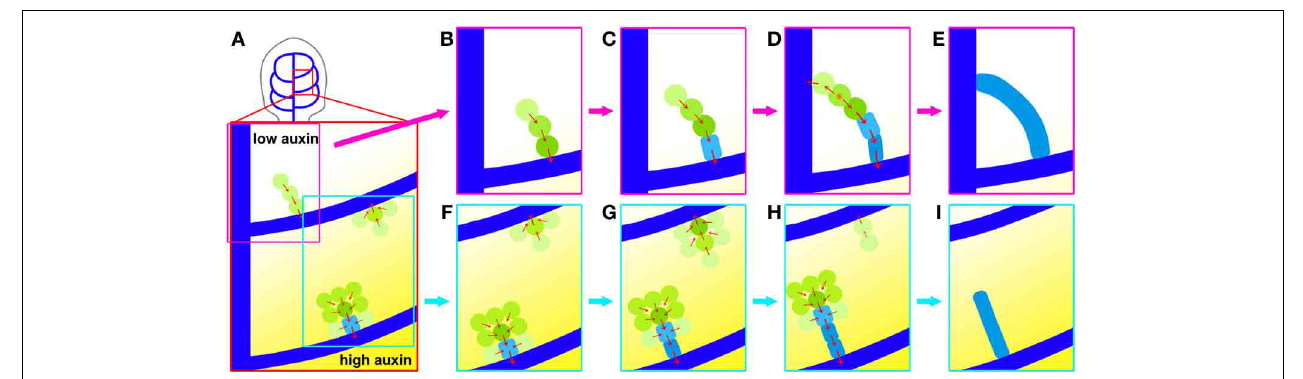
FIGURE 8 | Dynamics of higher-order vein patterning. (A) top: location of area enlarged below, hPED forming in higher auxin environment (bottom examples in stronger yellow shading) more likely to be wider and have strong PIN1 (green) and some Athb8 (light blue) expression. (B,C) hPED extension and fusion via terminal addition; from preexisting PEDs (dark blue) primarily via the upregulation of PIN1 in new cells at the free end. (C–E) . Formation of connected hPED often by fusion at free end with another PED, generating bipolar cell (orange star). Onset of PIN1 upregulation and cell elongation coincides with vascular